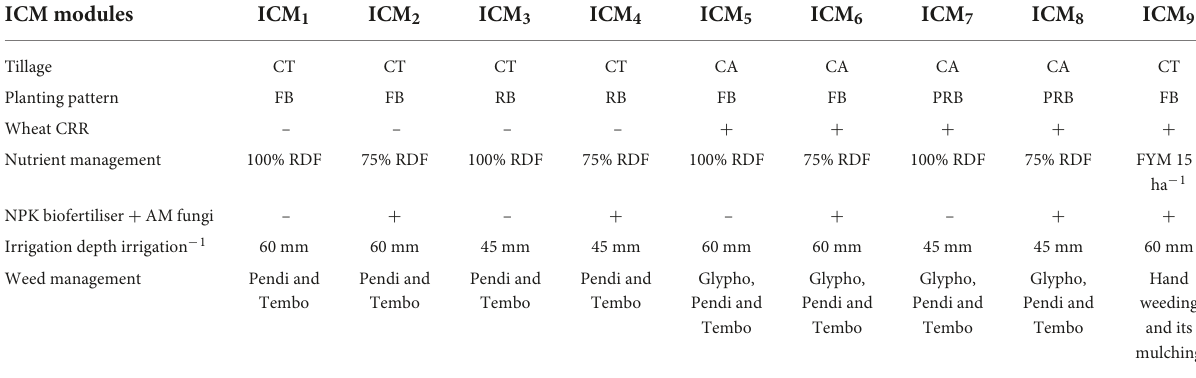
TABLE 2 Details of nine ICM modules (main plot) followed in maize/maize + blackgram system. ICM